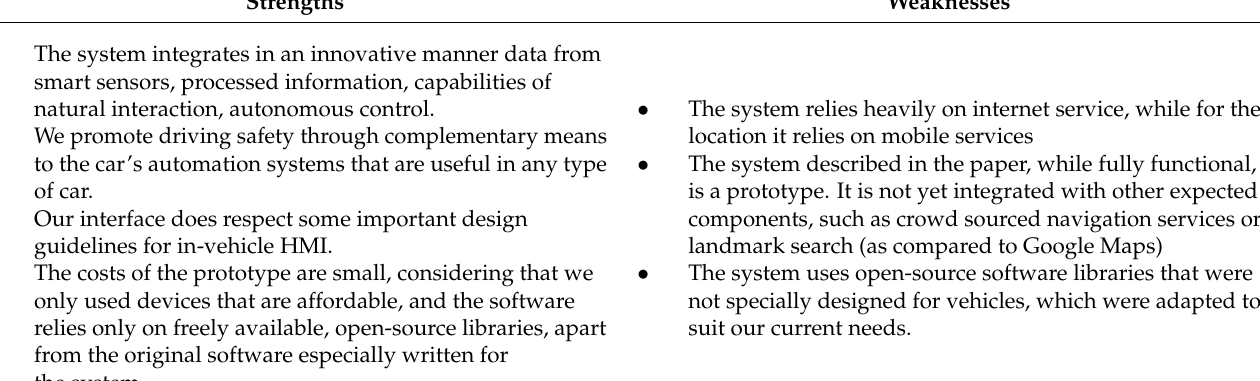
Table 2. SWOT analysis of the proposed in-vehicle